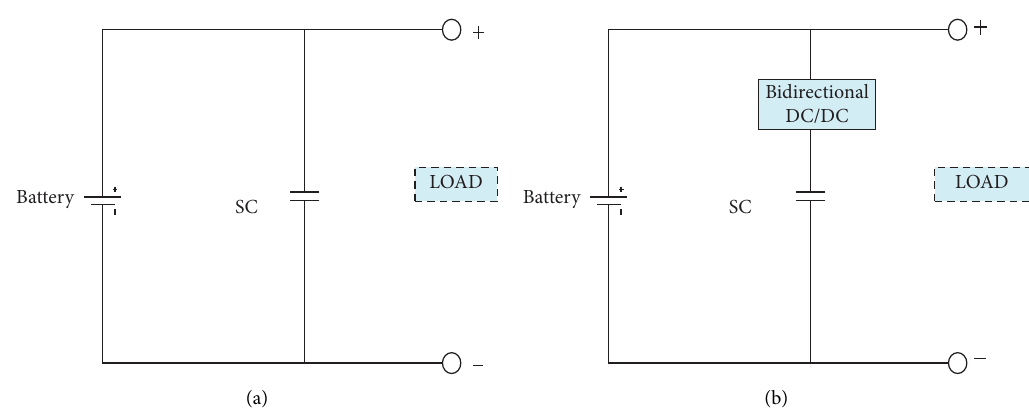
Figure 11: General diagram of an ESS and HESS; (a) ESS; (b)